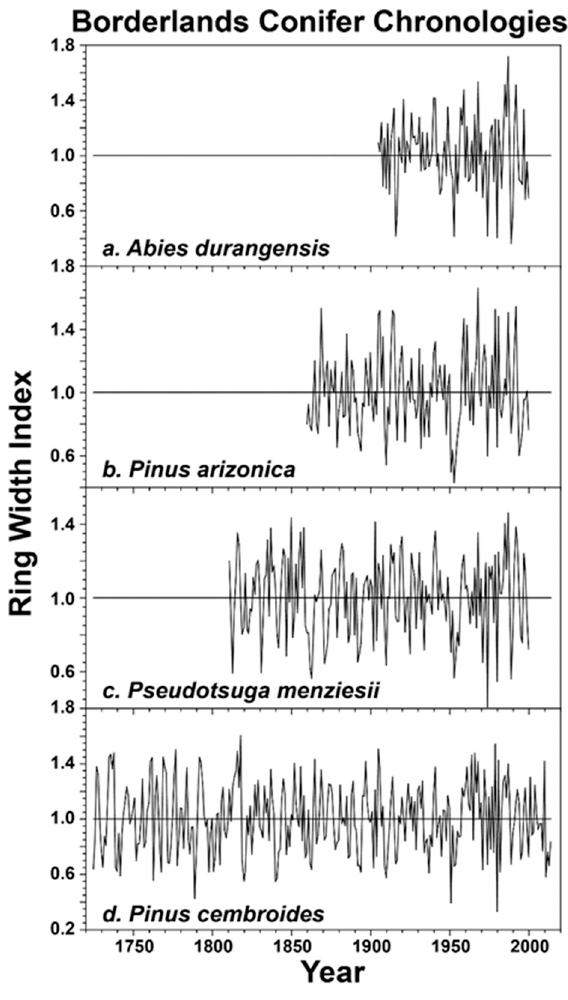
Figure 2. Regional average ring-width index chronologies based on two collection sites per species are plotted for their common intervals. The Abies average is based on ABCTXABDU and MDCMXABDU (site codes defined in Table 1), which are correlated at r = 0.58 for 1905–2000 ( a ). The P. arizonica average is based on MDCMXPIAZ and SANMXPIAZ, correlated at r = 0.47 for 1860–2000 ( b ). The P. menziesii average is based on BIGTXPSME and MDCMXPSME, correlated at r = 0.42 from 1811–2000 ( c ). The P. cembroides average is based on ELEMXPICE and NAMMXPICE, correlated at r = 0.62 for 1725–2014 ( d ). The correlation matrix for these four species chronologies is presented in Table